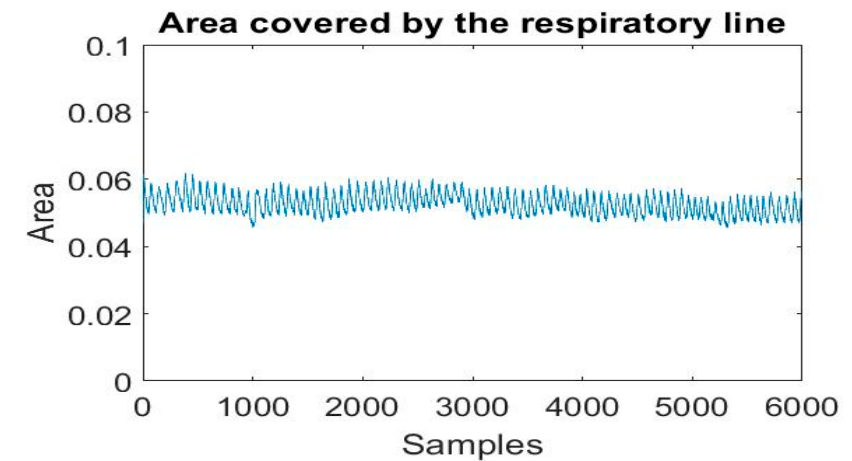
Figure 3. Noisy signal after finding area under curve. Number of frames in 1 s = 20. Number of frames in 1 min = 1200. Total number of frames in 5 min = 5×1200 = 6000.